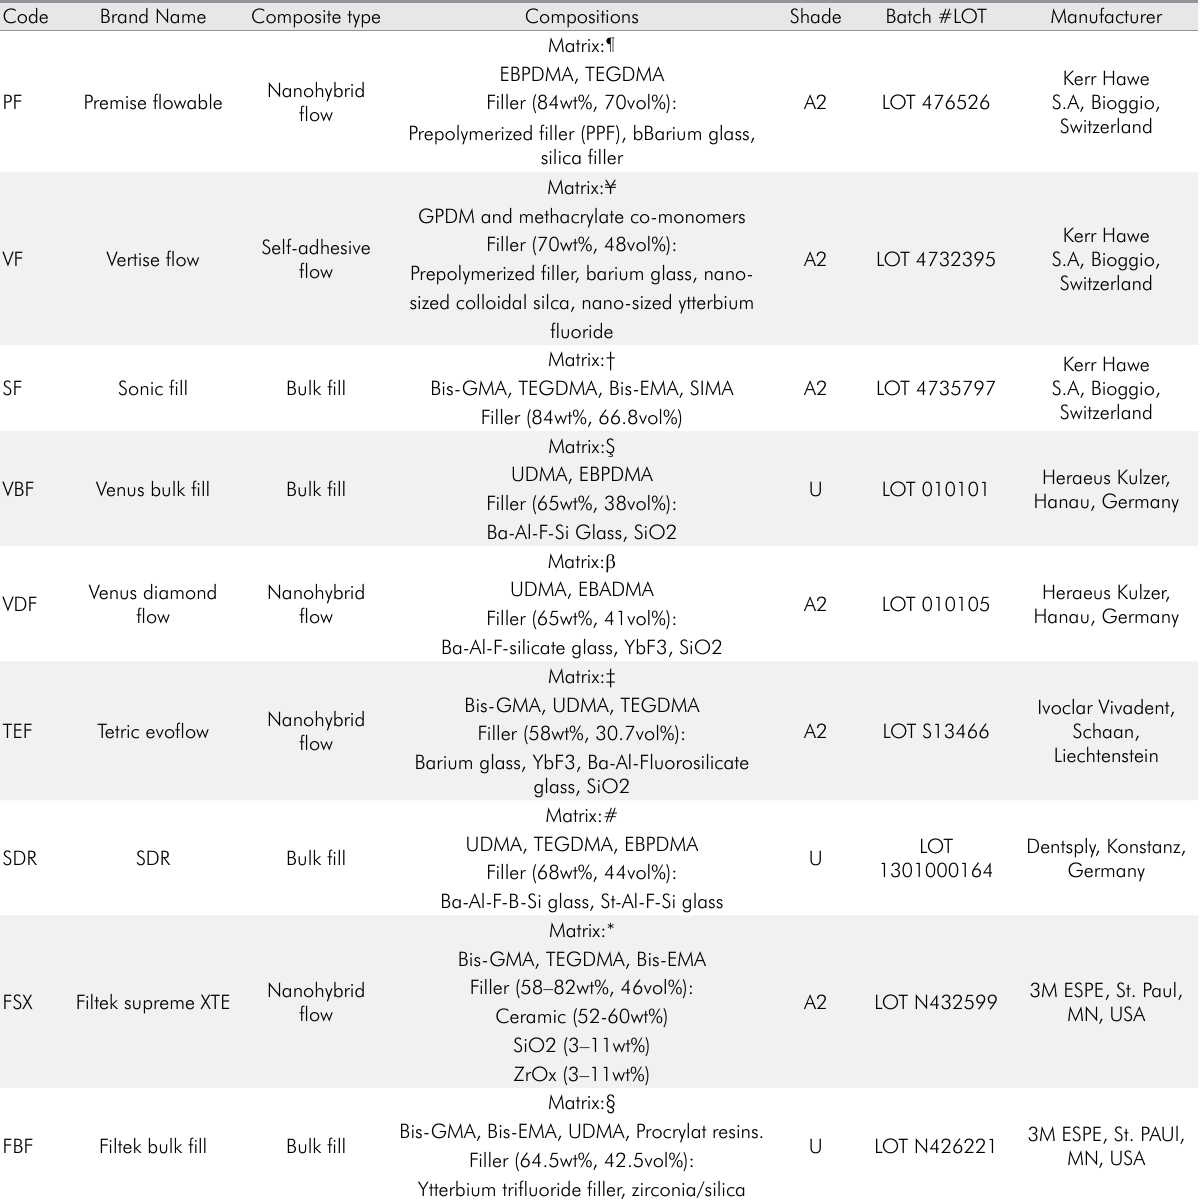
Table 1. Materials